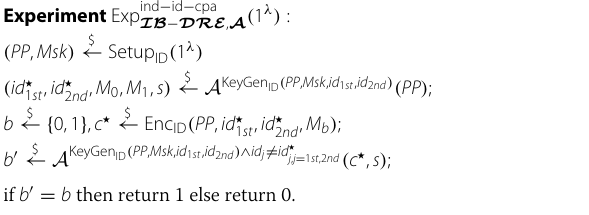
Table 4 IND-ID-CPA security for